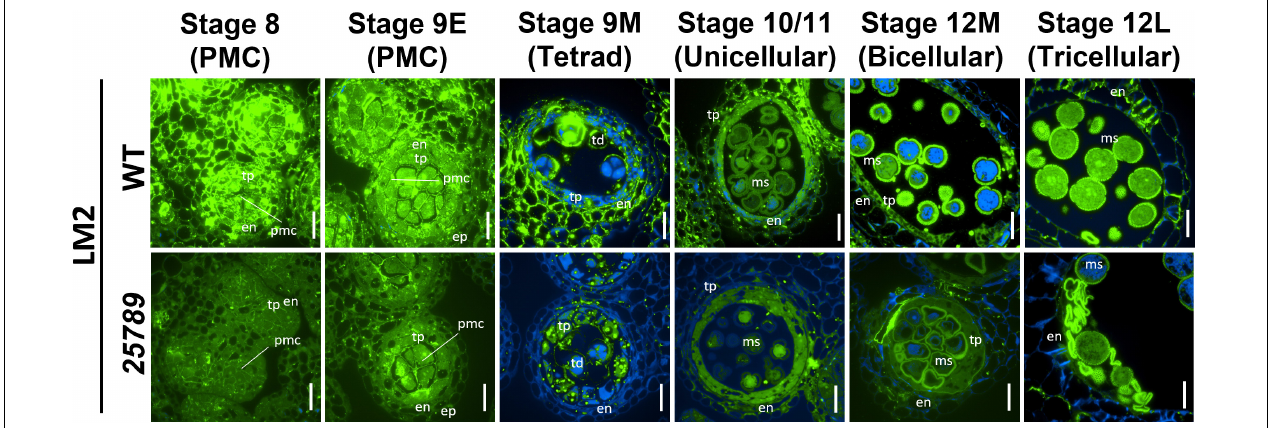
FIGURE 7 | Distribution of LM2-epitope labeling of AGPs in microsporocytes and microspores of galt25789 mutants and WT. Cross sections of resin-embedded anthers of WT (Col-0 ) and galt25789 from stages 8 to 12L were labeled with LM2 primary antibodies followed by Alexa Fluor 488-labeled secondary antibody labeling subsequently. Fluorescence of Alexa Fluor 488 (green) and autofluorescence (blue) was separately captured by epifluorescence microscopy and merged. Scale bar = 20 µ m. en-endothecium; ep-epithelium; ms-microspore; pmc-pollen mother cell; td-tetrad;